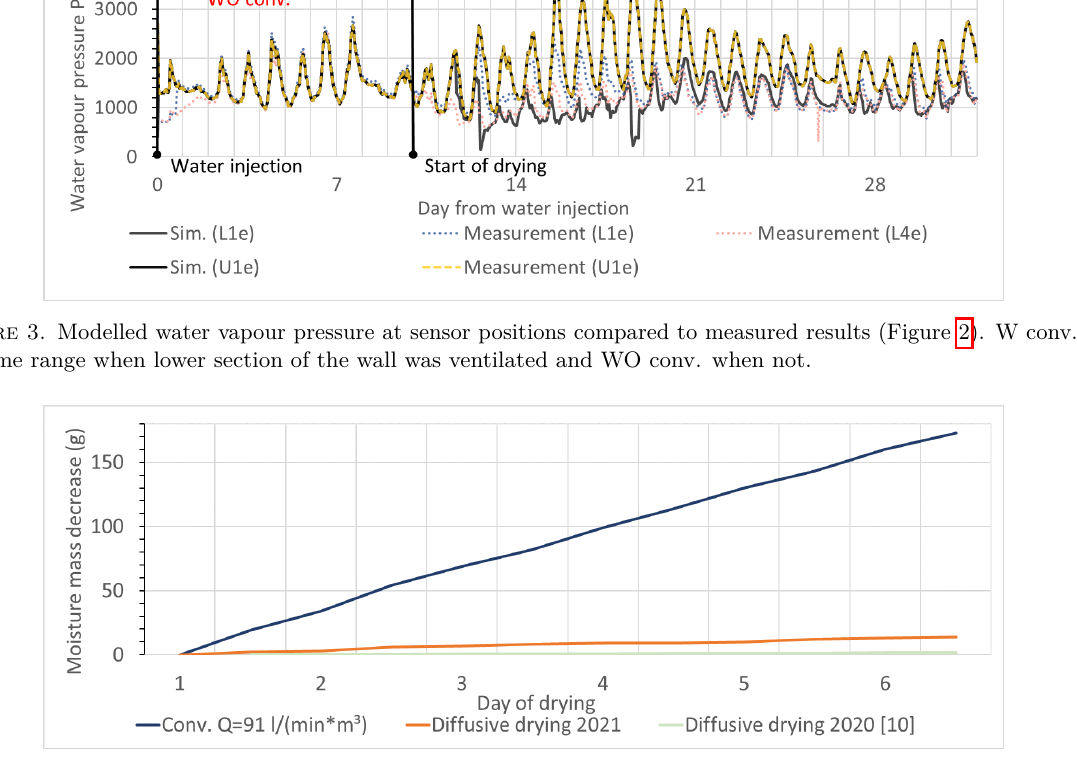
Figure 4. Moisture dry-out at stable temperature conditions (Figure 1). Diffusive drying 2020 refers to a previous research on vapour retarding and vapour permeable tape performance